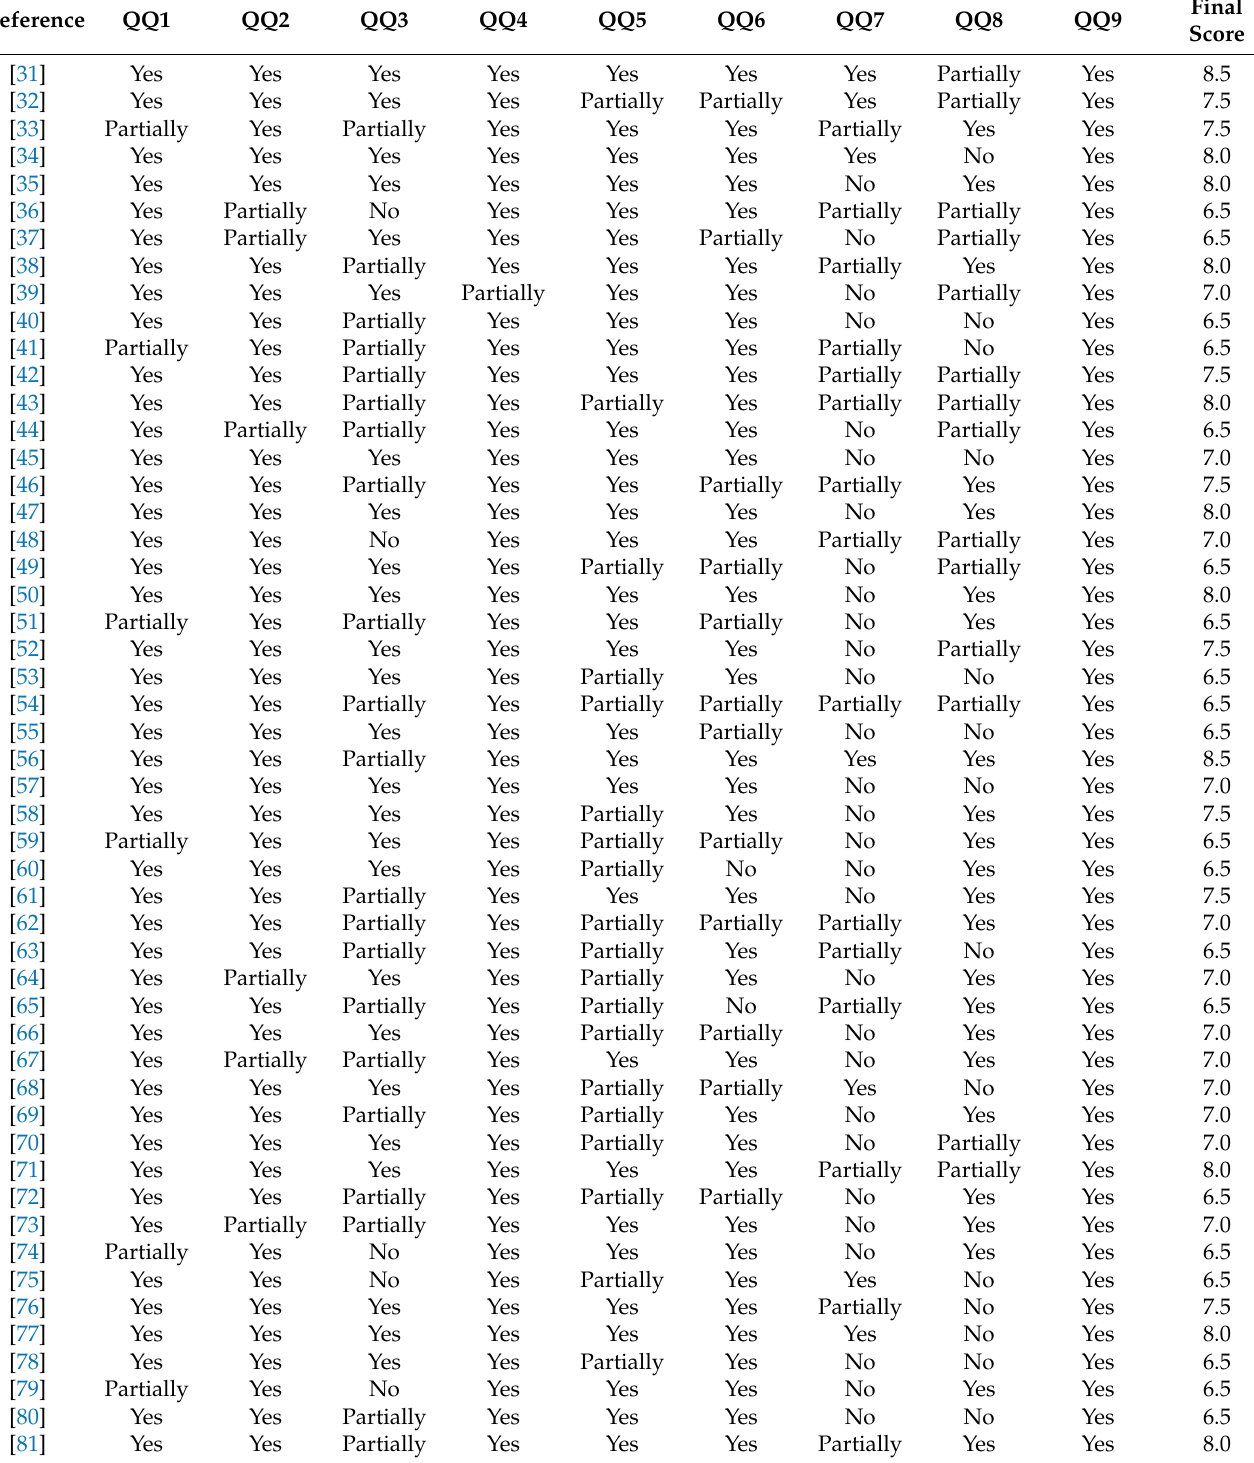
Figure 3 represents the number of papers selected per database on the left side and the number of papers classified per source and year on the right side. The selected articles are those obtained at the beginning of the review and the classified articles are those